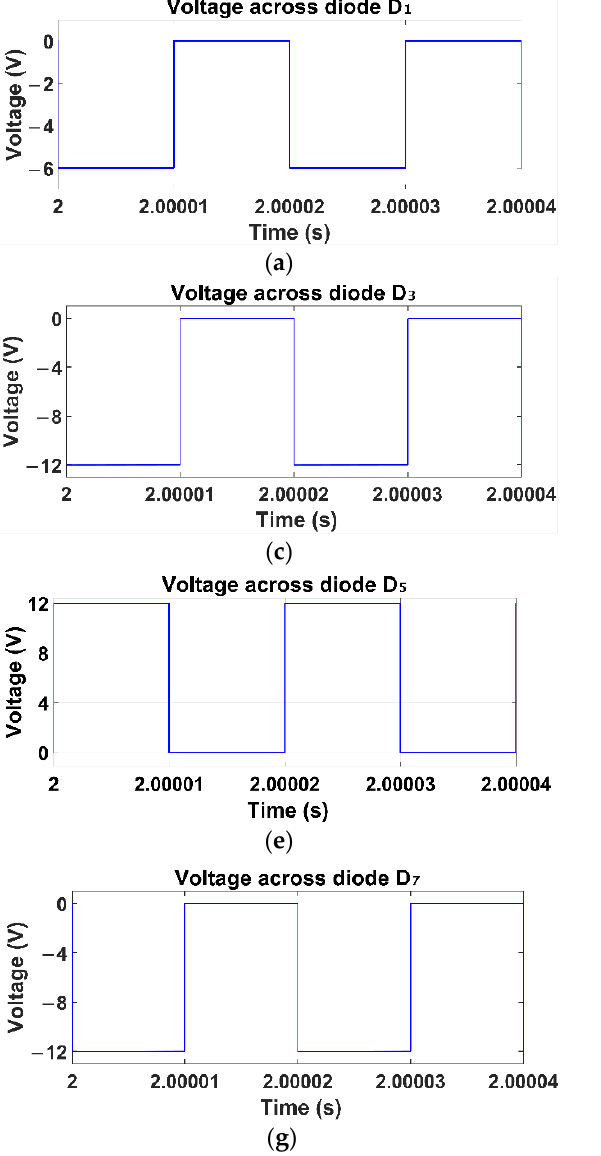
Figure 7. Voltages across diodes and MOSFET at D = 0.5 and V in = 3 V during ON and OFF modes. ( a ) Voltage across D 1 , ( b ) voltage across D 2 , ( c ) voltage across D 3 , ( d ) voltage across D 4 , ( e ) voltage across D 5 , ( f ) voltage across D 6 , ( g ) voltage across D 7 , and ( h ) voltage across MOSFET.